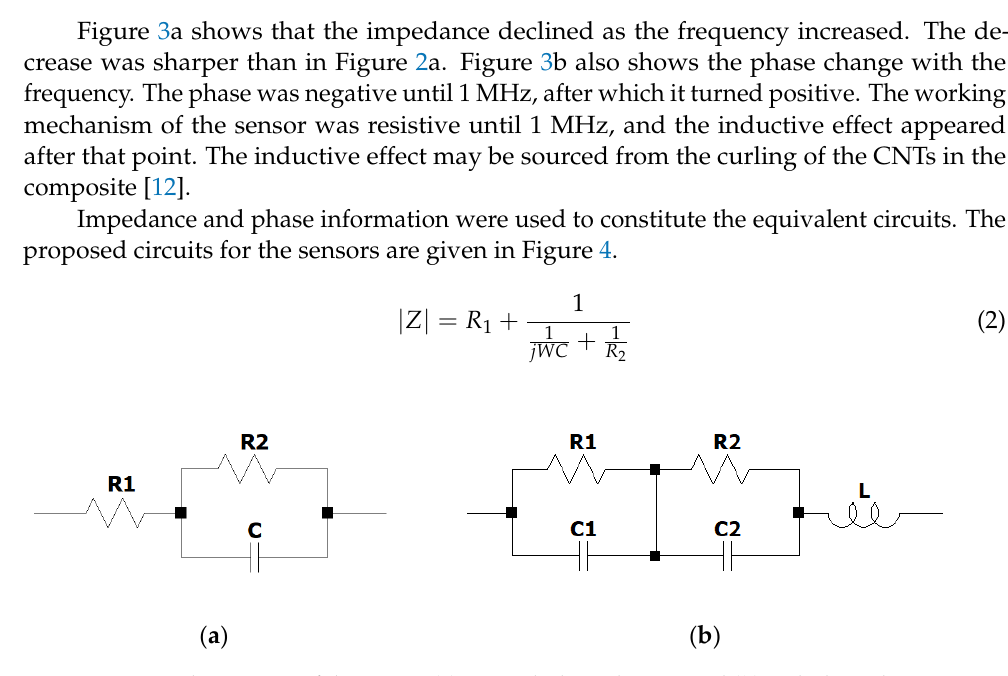
Figure 3. For the sensor including glycerin: ( a ) Impedance amplitude versus frequency relation and ( b ) Phase angle versus frequency relation .